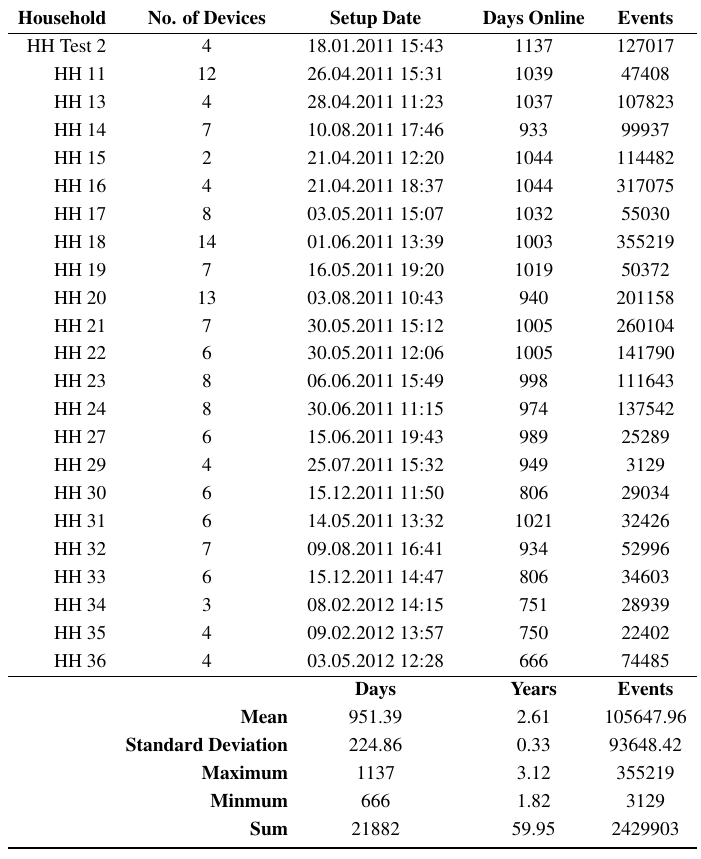
Table 5. The number of collected events per participating household.